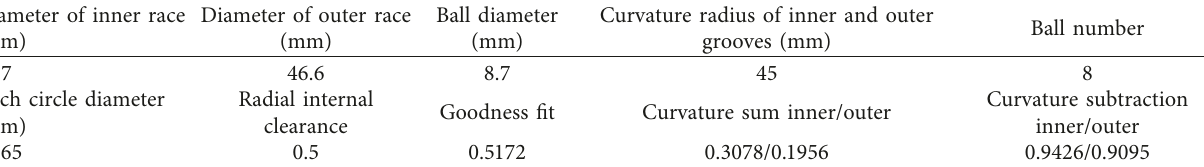
Table 3: Bearing basic parameters.